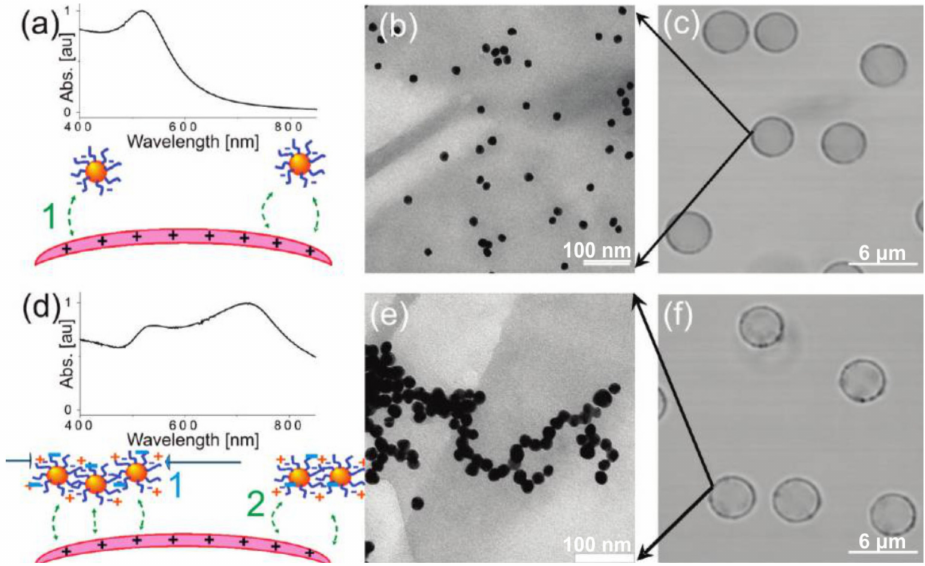
Figure 3. The influence of NPs distribution on absorption spectrum of microcapsules with NPs-modified shell. ( a ) Absorption spectrum for nonaggregated NPs and corresponding, ( b ) TEM image of nonaggregated NPs on a microcapsule, and ( c ) CLSM image of microcapsules; ( d ) Absorption spectrum for aggregated NPs and corresponding, ( e ) TEM image of aggregated NPs on a microcapsule, and ( f ) CLSM image of microcapsules [54]. Copyright 2010 American Chemical